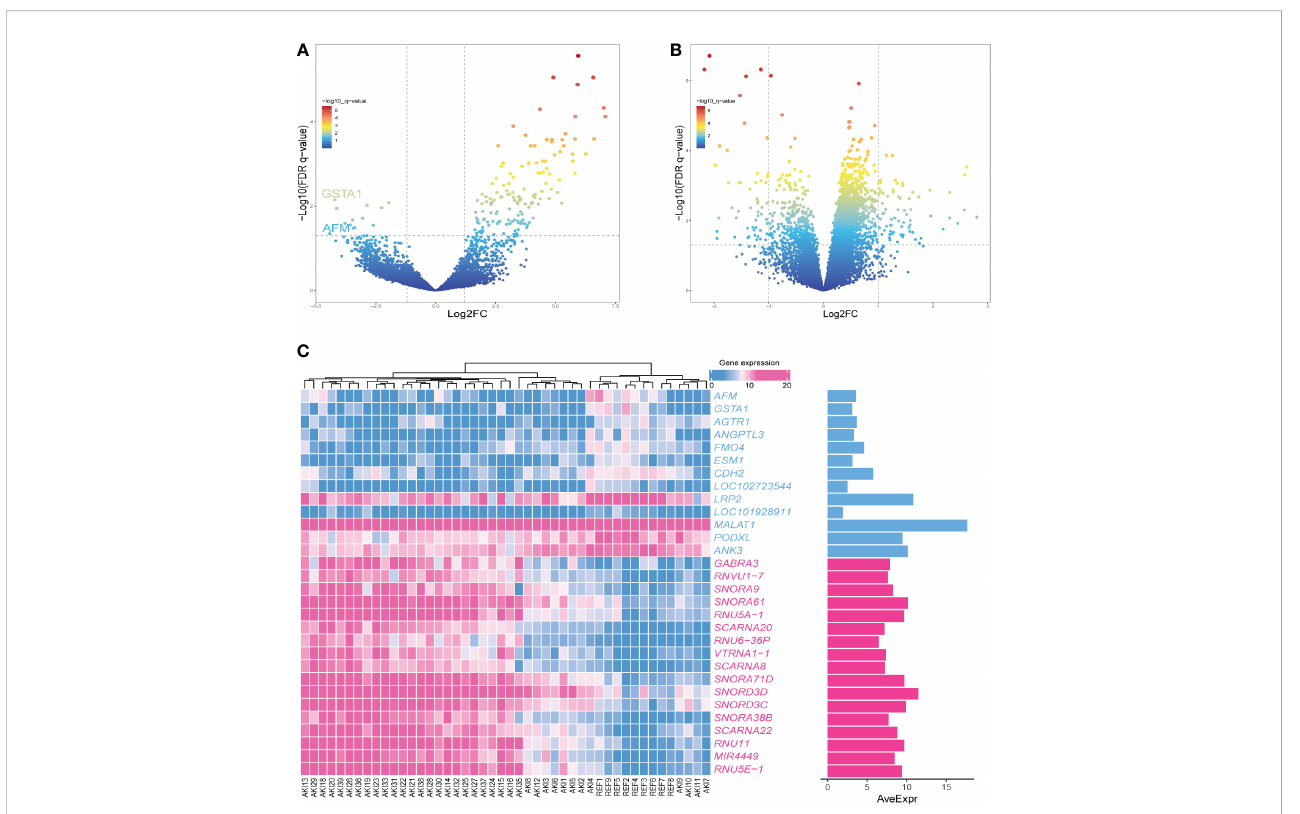
Figure 5F. Also, the expression of AFM in various tissues or cells was queried in the ProteomicsDB database (ProteomicsDB; https://www.proteomicsdb.org/), and it was found to be highly expressed in monocytes (Figure